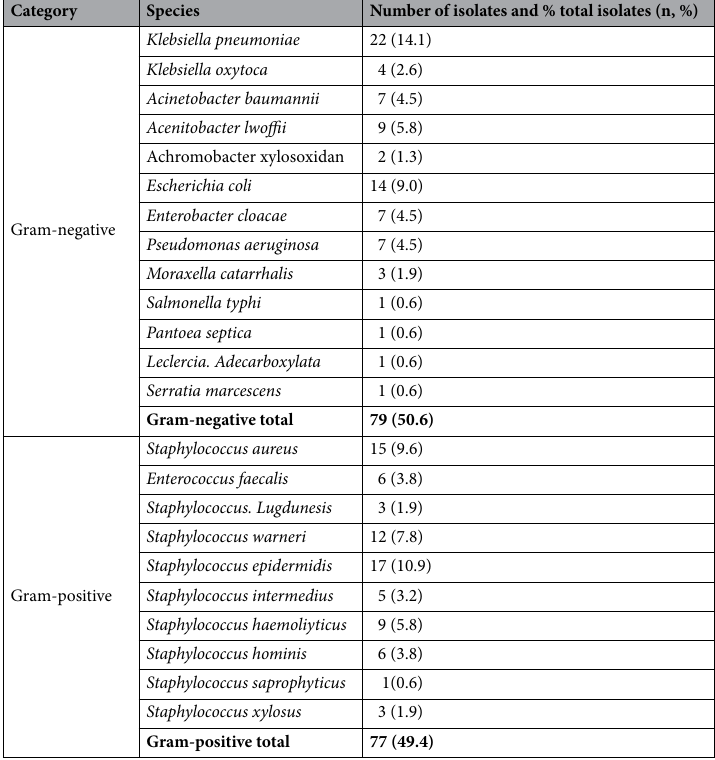
Table 2. Percentage distribution of blood-born bacteria among the total isolates (n = 156). Significant values are in